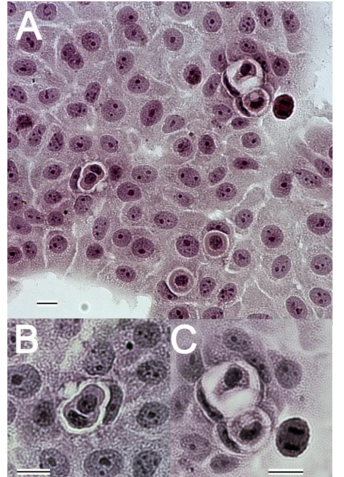
Figure 3. Photograph of pancreatic cancer cells BxPC3 cultured on coverslips stained with Haematoxylin. ( A ) General view of BxPc3 cells with entotic structures. For about 100 cells visible in the field of view, five demonstrate three characteristic features of entosis: (a) CIC structure (one cell is within the second one); (b) the outer cell is stretched with a crescent-shaped nucleus; and (c) the characteristic entotic vacuole is formed around the inner cell. The outer cell demonstrates normal nuclei with sharp edges and well-visible nucleoli, without features of chromatin condensation or chromatin vacuolisation. The cytoplasm of the host cells is stretched and seems to be involved in formation of the big vacuole that surrounds the inner cell. The internal cell has preserved the cytoplasm, its nucleus is well delimited without regressive changes; (original magnification 100 × ) ( B , C ) Selected entotic structures. ( B ) Double cell-in-cell structure; (original magnification 400 × ). ( C ) Two entotic figures with huge entotic vacuoles; (original magnification 400 × ). All scale bars: 10 µ m. Data by Izabela Mlynarczuk-Bialy (M.D., Ph.D.) Magdalena Kowalczyk